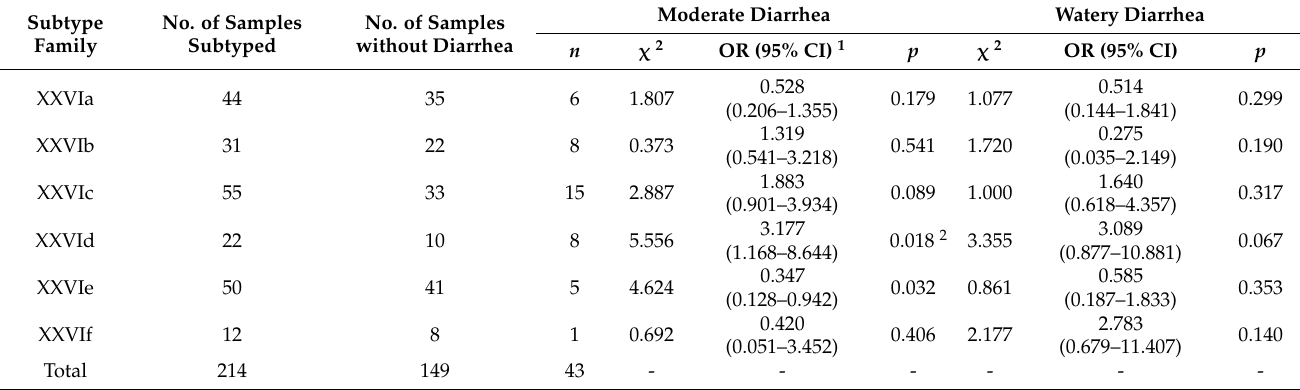
Table 5. Difference in the frequency of Cryptosporidium bovis subtype families in dairy cattle with different diarrhea statues. Subtype